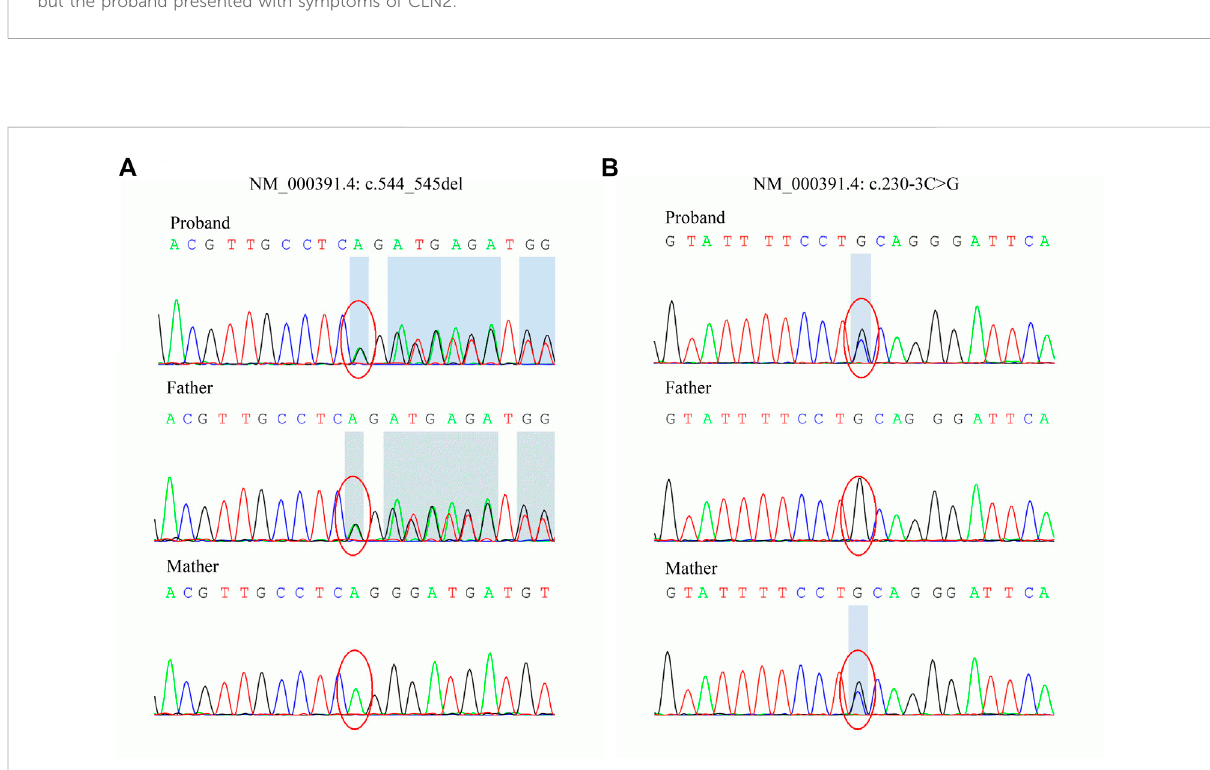
FIGURE 2 Sangersequencingofthe TPP1 geneinthefamily. (A) Thec.544_545delvariantiscarriedbytheprobandandfather. (B) Thec.230-3C > Gvariant is carried by the proband and